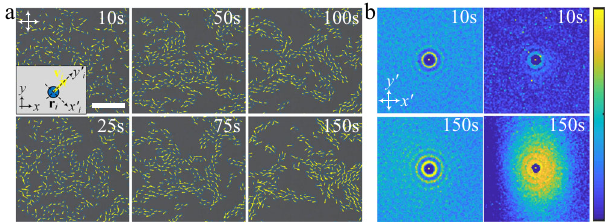
Fig. 3 Formation of directron fl ocks. a Polarizing micrographs of directrons ( U = 16.2 V, f = 100 Hz.) with their velocities represented as yellow arrows at different times after applying the electric fi eld. Scale bar 100 μ m. The crossed polarizers are indicated as white arrows. The time after the application of the electric fi eld is indicated. A laboratory coordinate frame ( x y ) and a local coordinate frame ( x' y' ) are de fi ned in the inset. b 2D radial distribution functions ( g ) ( fi rst column) and 2D spatial velocity correlation functions ( g v ) (second column) of the directrons colored according to the color bar at 10 s and 150 s after applying the electric fi eld, respectively. The color bar changes linearly from 0 (dark blue) to 4 (light yellow) for g and from 0 (dark blue) to 1 (light yellow) for g v . Image sizes represent an area of 200 μ m × 200 μ m. The 2D spatial velocity correlation functions are averaged over 5 s (ten